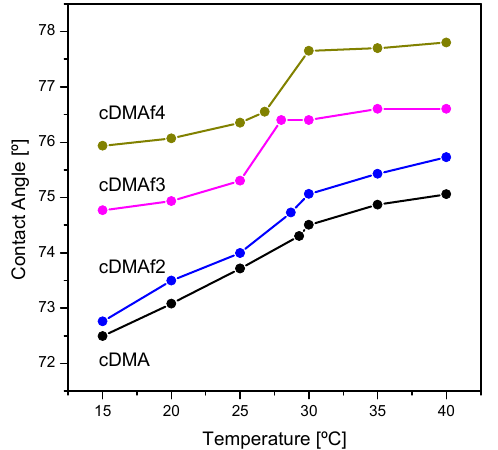
Figure 6. Contact angle values for functionalized samples and pure copolymer measured at different temperatures.